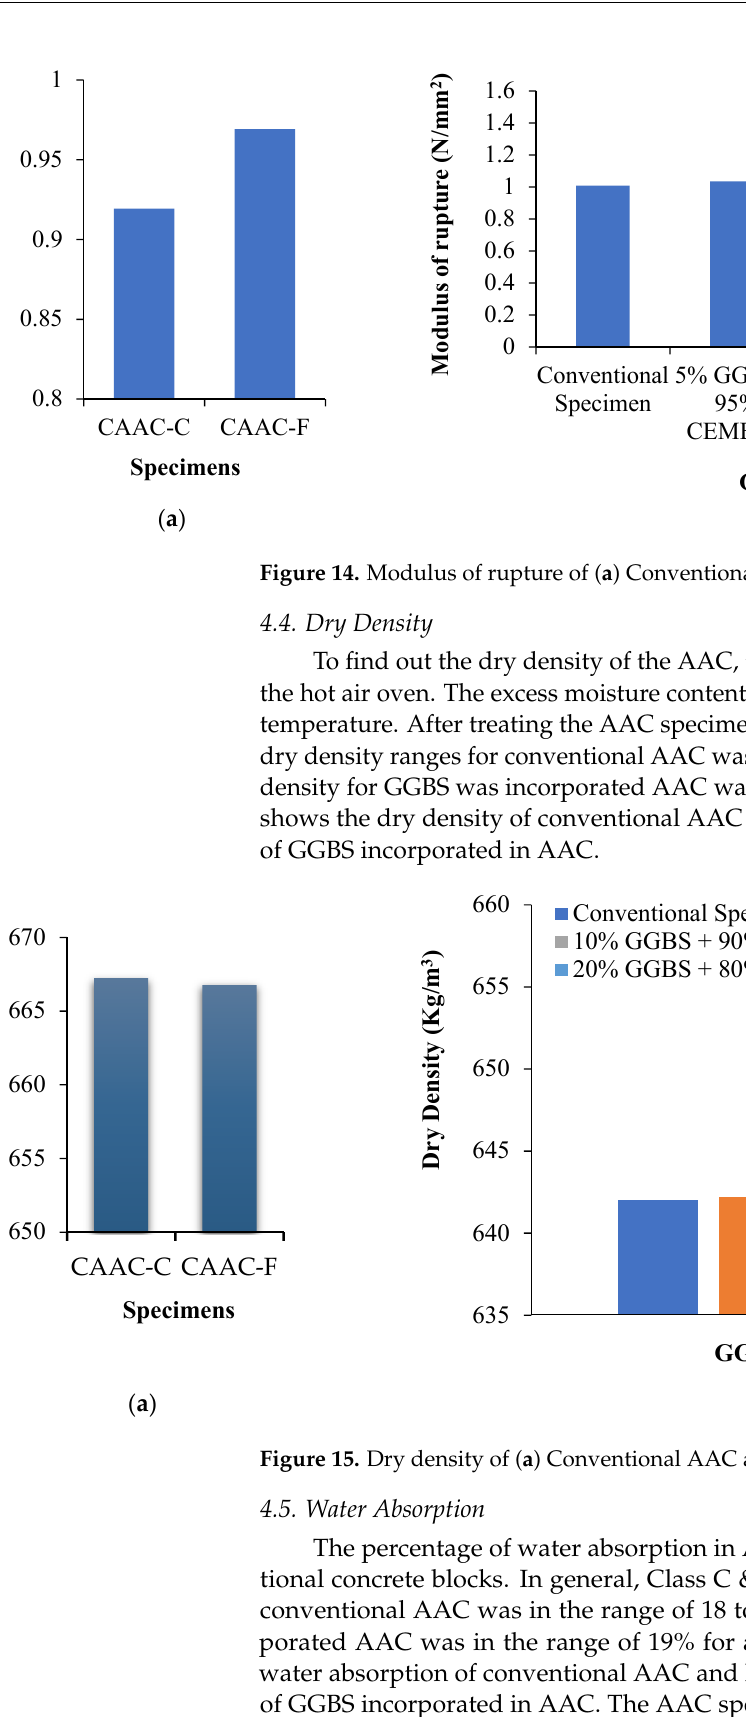
Figure 13. Depiction view of the modulus of rupture experimental test setup.